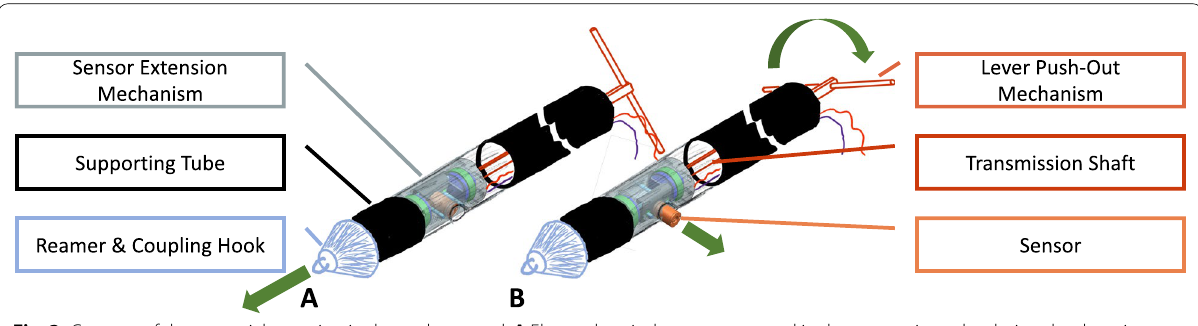
Fig. 3 Concept of the potential mapping in the underground: A Electrochemical sensor protected in the supporting tube during the dragging through the underground and B After turning the lever, the sensor is pushed out from inside the tube towards the underground, and the measurement procedure is started; after the measurement, the sensor goes back to the initial position in the case. The direction of the green arrows shows the turning direction of the lever arm and the direction of the movement of the